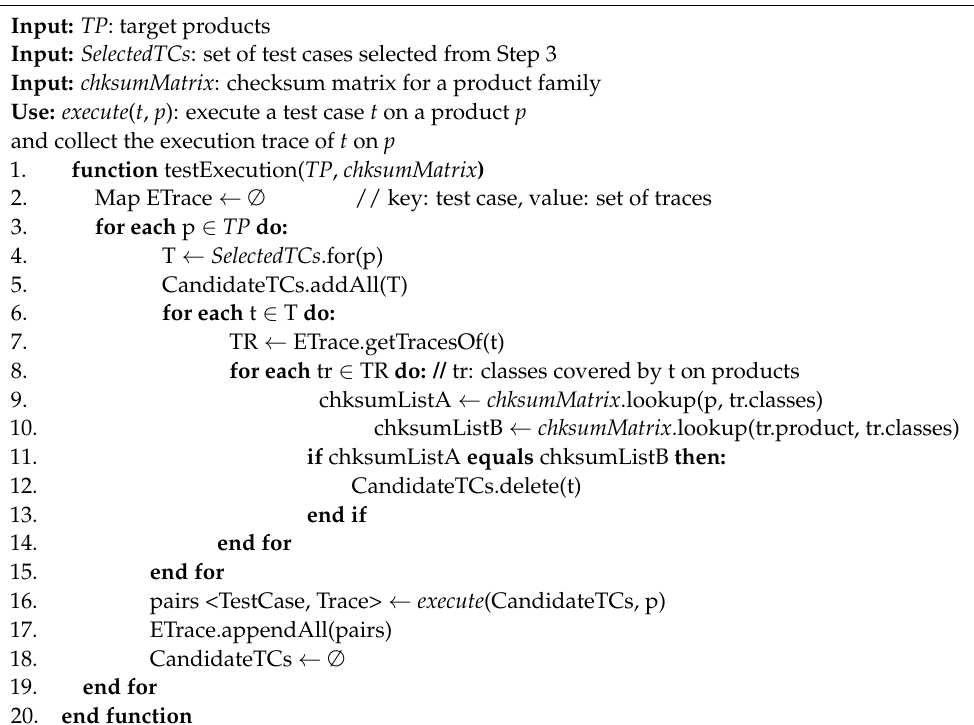
Algorithm 1 An algorithm for avoiding equivalent test